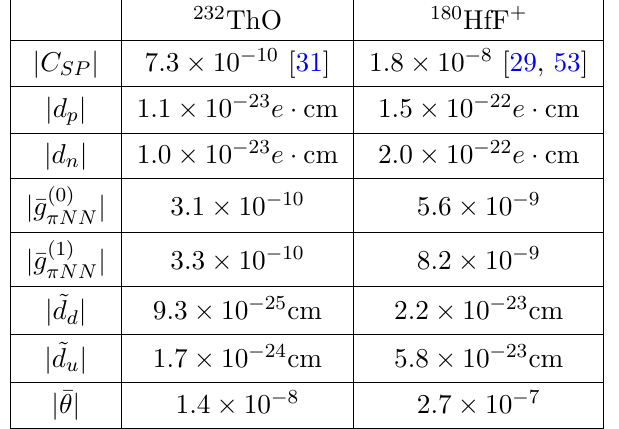
Table 2 . Limits on absolute values of CP -violating hadronic parameters arising from the rela- tions (4.3), (4.8), (4.10) and (4.13) upon implementing the constraints on the constant C SP from the 180 HfF + [29, 53] and 232 ThO [31]